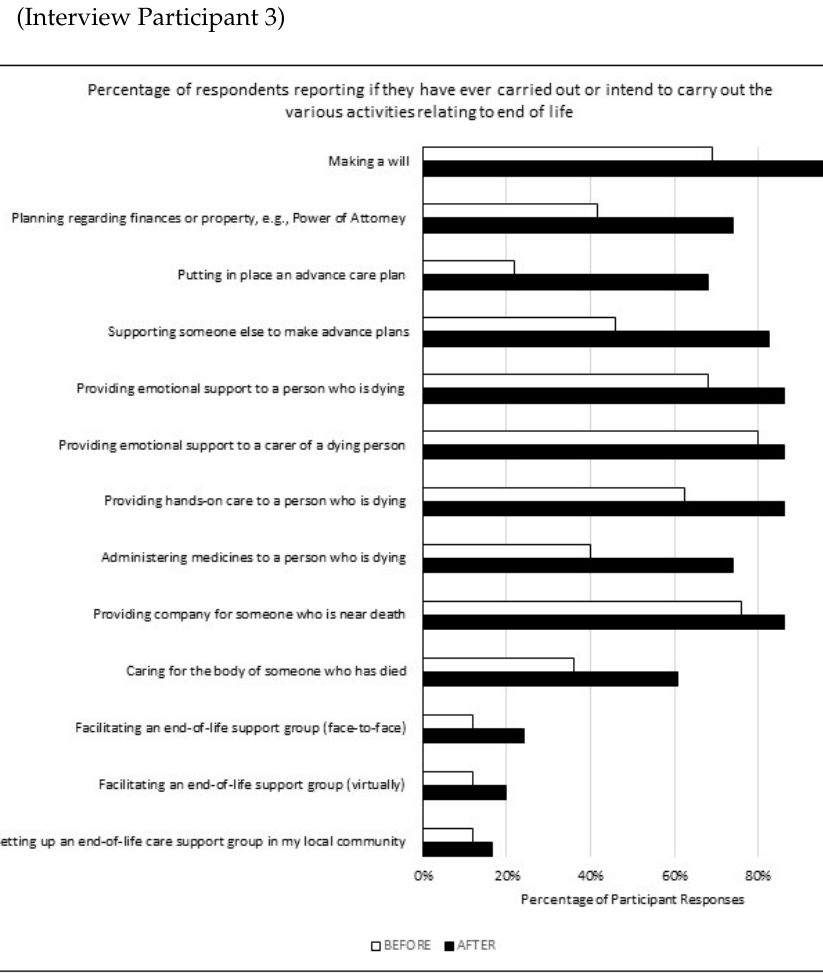
Figure 5. Decisions and Intentions to Support End-of-Life Care Needs.